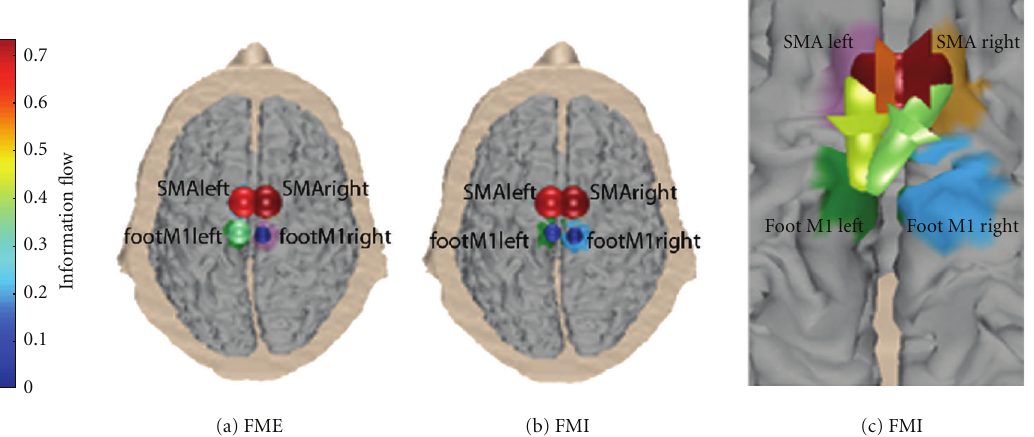
Figure 9: FCNs of one representative subject during foot motor tasks. Information outflow from SMAs and primary foot motor areas during (a) Foot Motor Execution (FME) and (b) Foot Motor Imagery (FMI). (c) Information exchange of those areas during Foot Motor Imagery (zoom